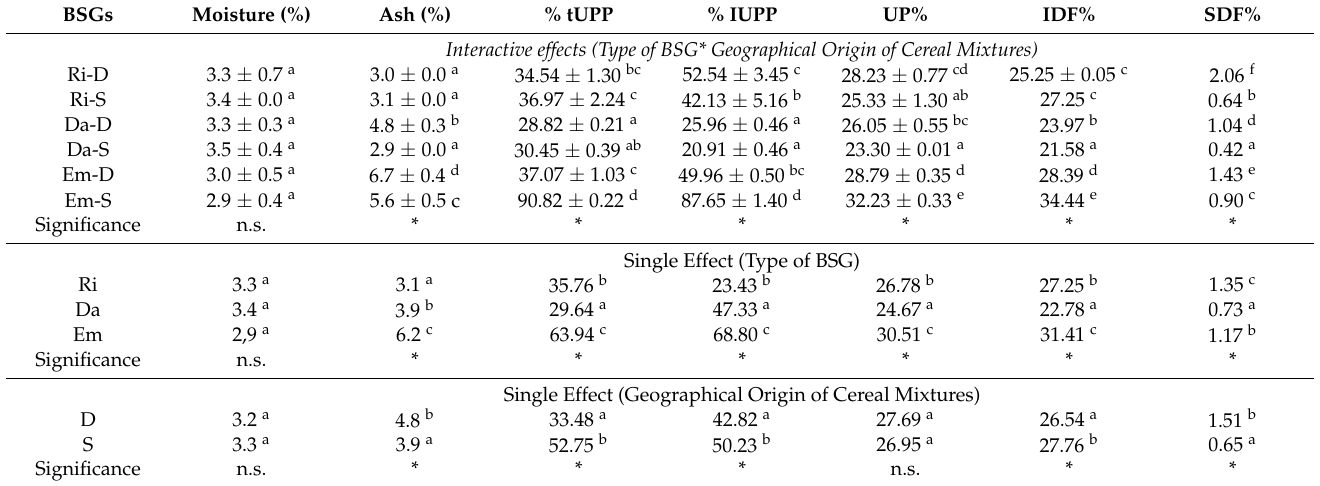
Table 3. Single and interactive effects of type of BSG and geographical origin of the cereal mixtures used in brewing on physical and chemical characteristics of